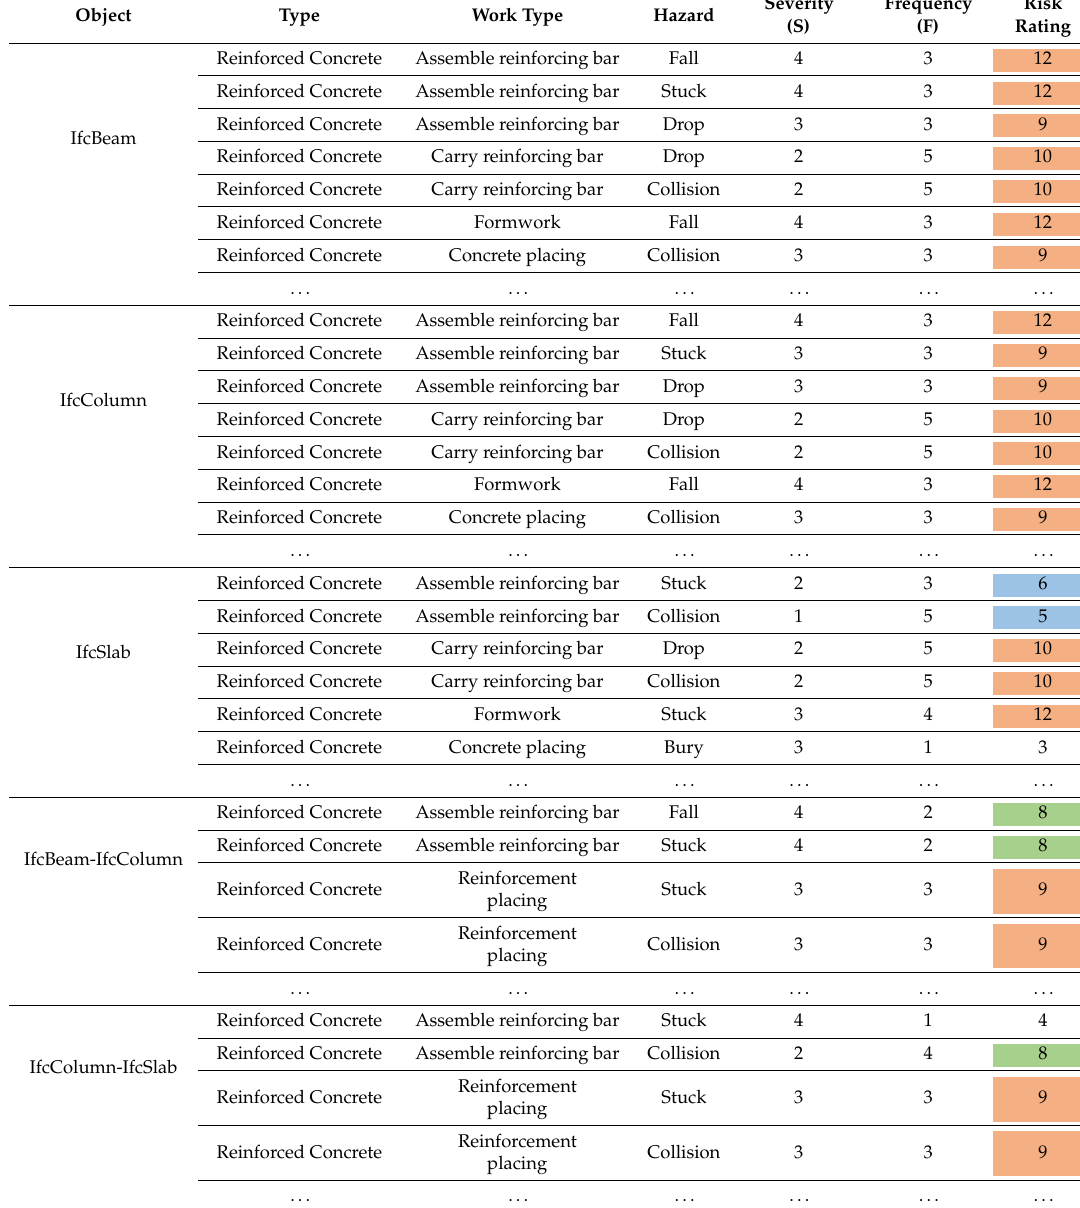
Table 5. Results of risk assessment of column, beam and